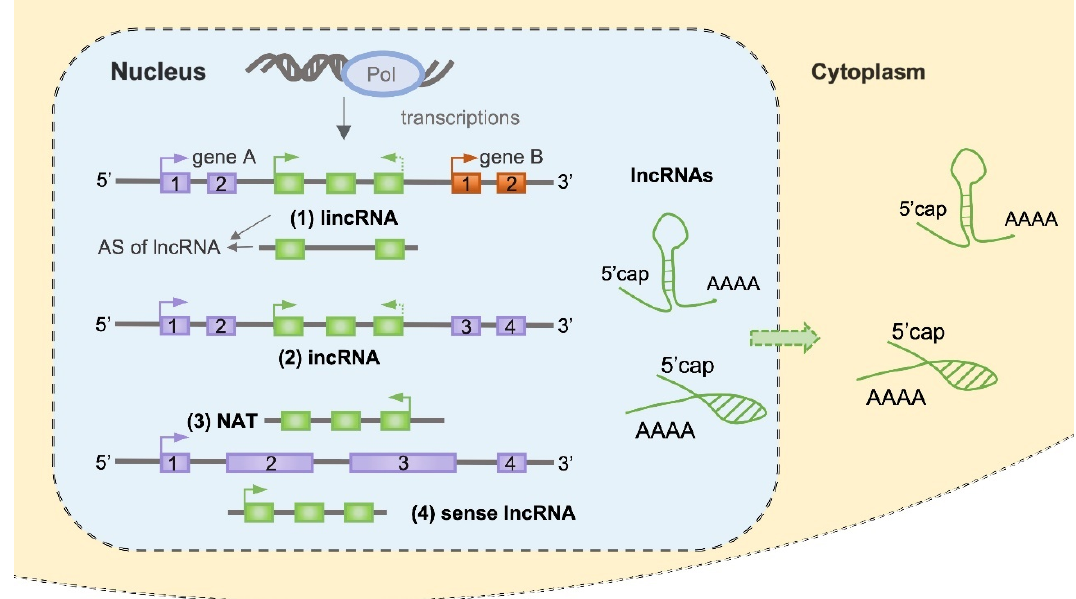
Figure 1. Classification of lncRNAs based on their orientation and positions related to other genes. LncRNAs are transcribed by nuclear RNA polymerases in plants. Based on their orientation and positions related to other genes, the major classes of lncRNAs could be classified as (1) lincRNAs (found in intergenic regions), which could be transcribed in both directions; (2) incRNAs (intronic ncRNAs), which could be transcribed in both directions; (3) NATs (natural antisense transcripts occur in most protein coding genes); (4) sense lncRNAs, overlapping the protein coding genes. LncRNAs could generate multiple splice variants from one gene and display a remarkable degree of AS (alternative splicing), which showed up in lincRNA as a representative. Cytoplasmic LncRNAs have been found in Drosophila and mammals, while there is still a lack of solid evidence in plants.